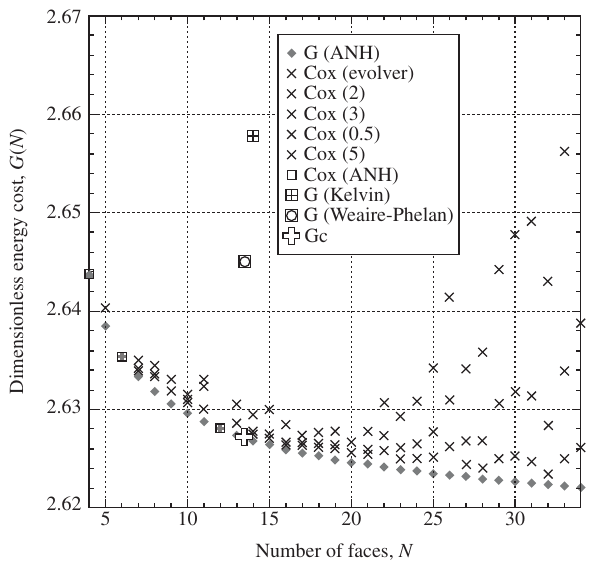
Figure 4. Dimensionless energy cost, G , vs. number of faces on a polyhedral cell, N . Data are shown for a narrow ( ≈ 2.6%) range of G -values for ANH’s (black diamonds); for a selection of constructible irregular polyhedra and ANHs (crosses and open squares, respectively), as measured by Cox* using computer simulation; for Kelvin’s orthic tetrakaidecahedron at N = 14; for the Weaire-Phelan duplex tiling at N = 13.5; and for the critical ANH at N = 13.397. The G-values for highly symmetric ANHs form a lower bound for every class of polyhedra tested in various topological face combinations. The range of G -values exhibited by various polyhedra with a fixed number of faces increases with N , as many more topological combinations become possible.